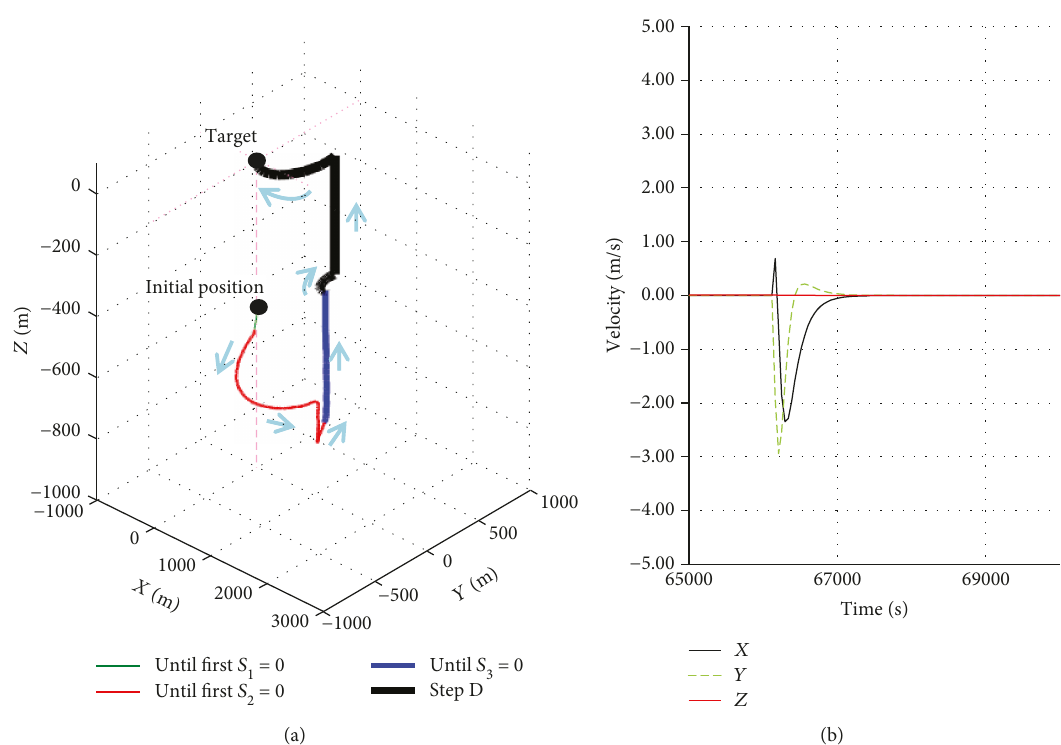
Figure 14: Position in case 3. (a) Position trajectory to the target. (b) Velocity histories around the